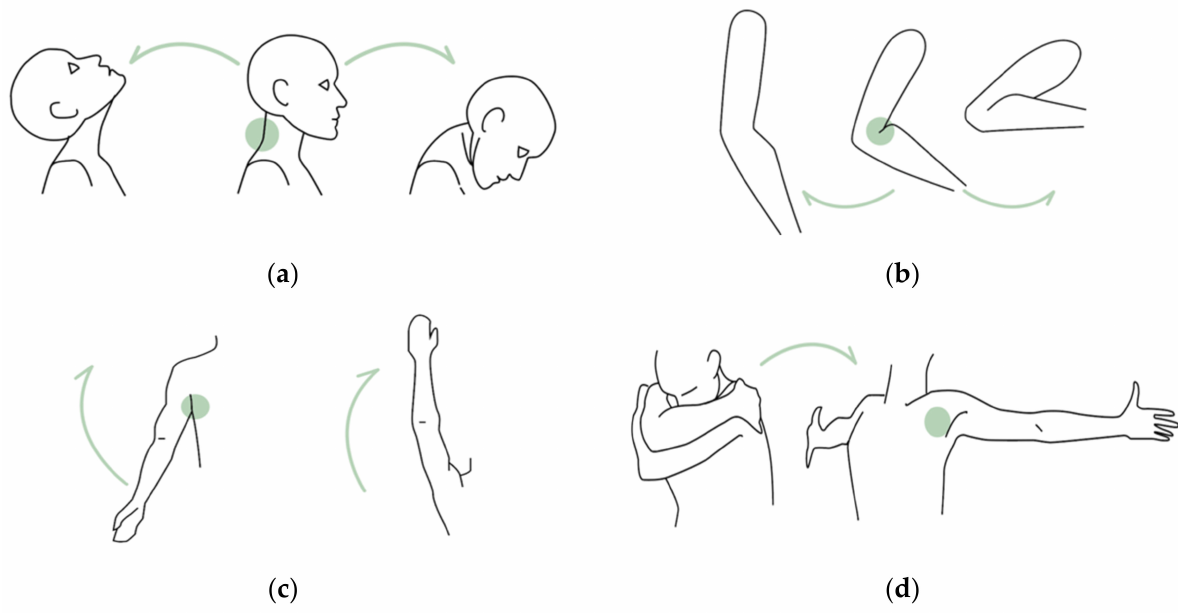
Figure 1. The body movements detected using our prototype: ( a ) neck flexion/extension; ( b ) elbow flexion/extension; ( c ) shoulder flexion/extension; and ( d ) open and closed arms. Green dots indicate the sensors’